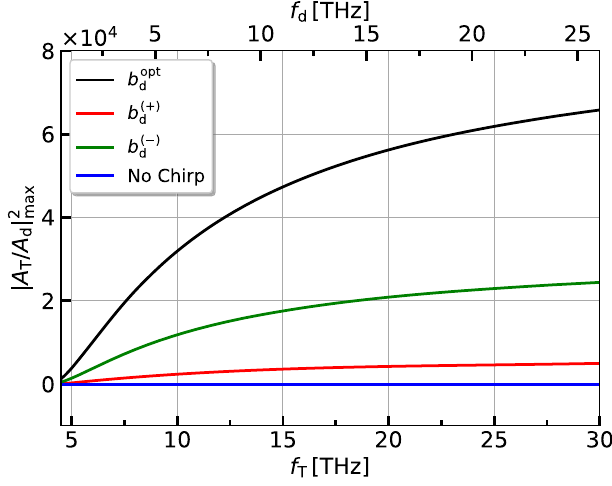
FIG. 2. Terahertz amplification gain versus its frequency for different chirp parameters, i.e., optimum chirp, b 10 − 4 and the case without frequency chirping. The upper horizontal axis shows the driver wave ’ s frequency. All parameters are the same as in Table